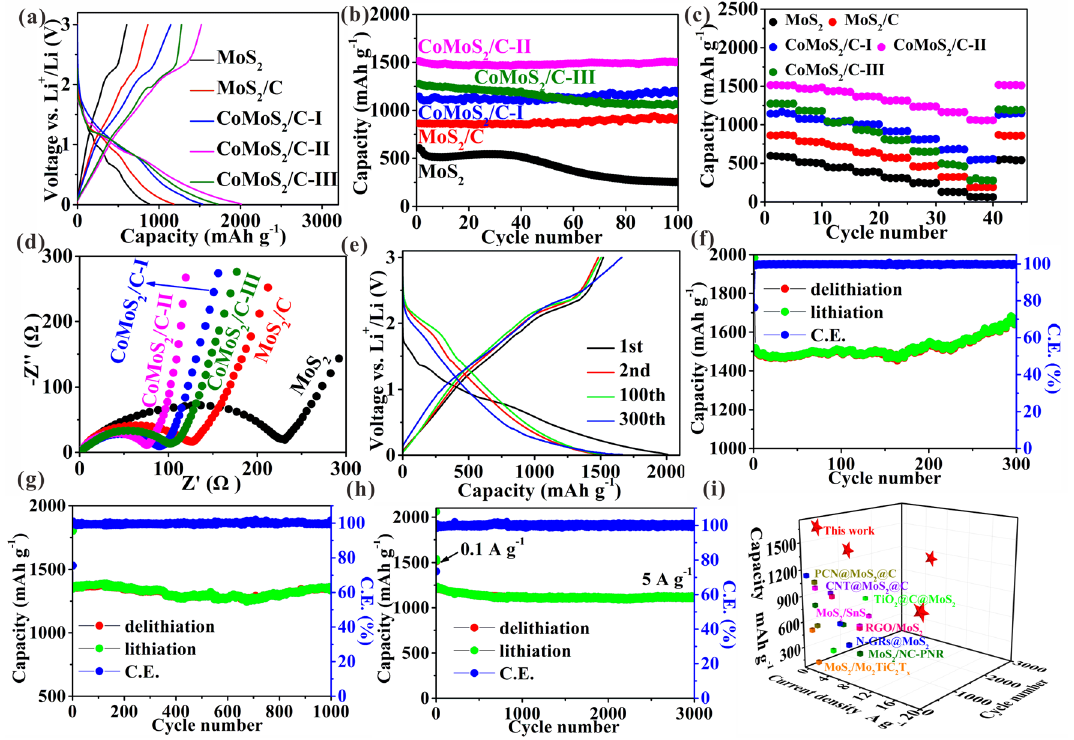
Fig. 3 Lithium-ion storage performance testing and comparison. a First lithiation/delithiation profiles at 0.1 A g −1 . b Cycling profiles at 0.1 A g −1 . c Rate profiles, and d Nyquist plots of all the prepared samples. e Lithiation/delithiation profiles at 0.1 A g −1 . Cycling profiles at f 0.1 A g −1 , g 1 A g −1 , and h 5 A g −1 of CoMoS 2 /C-II. i Performance comparison